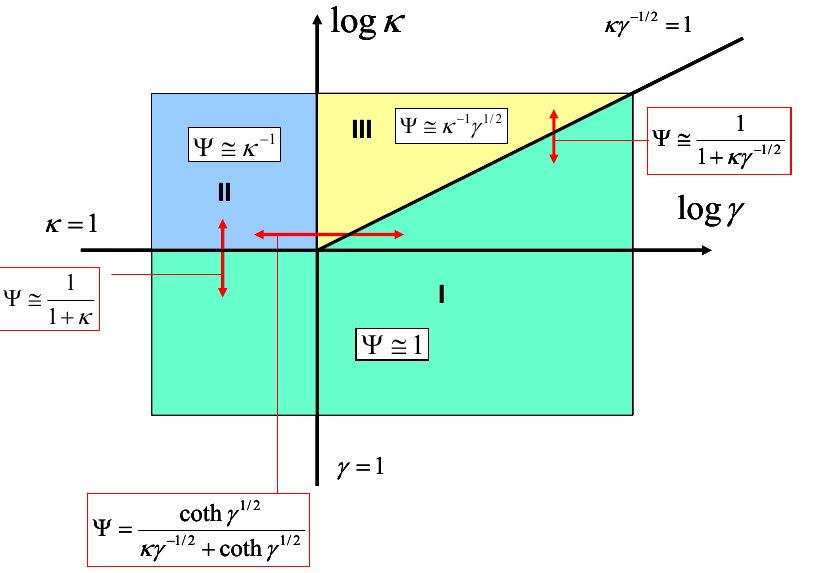
Figure 8. Kinetic case diagram (plot of log κ versus log γ ) for membrane free direct reaction and diffusion of electro-enzyme . Note that κ compares the rate of enzyme regeneration at the electrode with that of enzyme diffusion through the solution, whereas γ compares the rate of enzyme diffusion to that of homogeneous reaction between enzyme and substrate. In both cases approximate limiting expressions for the normalized flux and the expressions delineating the boundaries between specific cases are